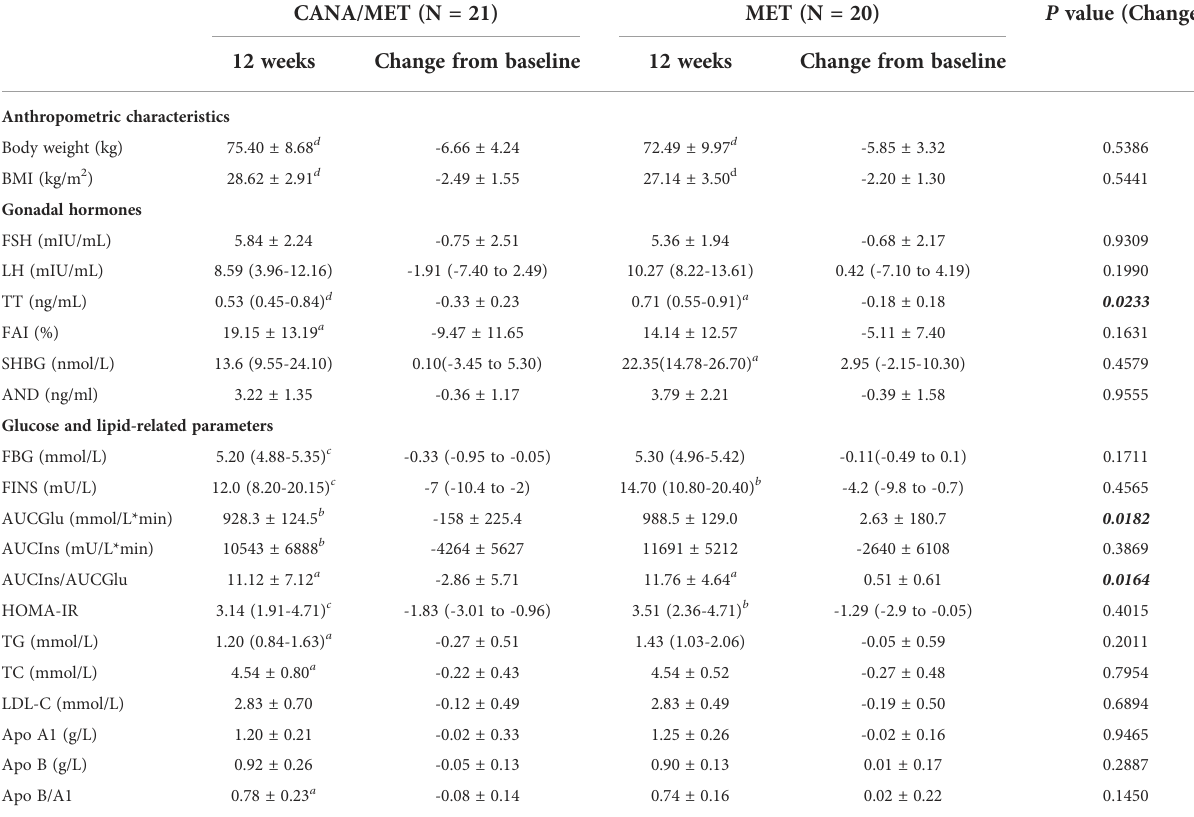
TABLE 2 Information of 12-weeks post treatment and changes in endocrine and metabolic pro fi le. CANA/MET (N = 21) MET (N = 20) P value (Change) 12 weeks Change from baseline 12 weeks Change from